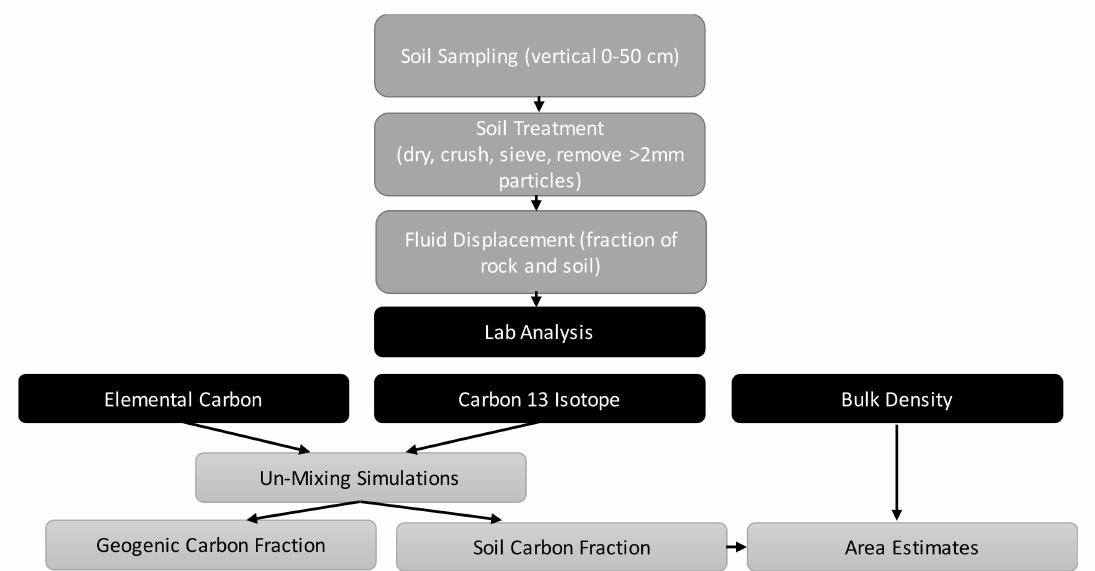
Figure 4. Overview of sampling and analytical measurements. Soil pits were excavated to reveal the soil profile at each of the eight replicates at each site. Litter samples were collected and soil samples were collected from 0–5, 5–10, 10–25, and 25–50 cm depth increments. Processed soil samples were analyzed for elemental and δ 13 C signatures and mass balance un-mixing simulations were used to separate the geogenic and soil C fractions, in which the carbon isotope was used as the tracer. Bulk density and rock fragment estimates from field samples assisted with areal estimates of soil